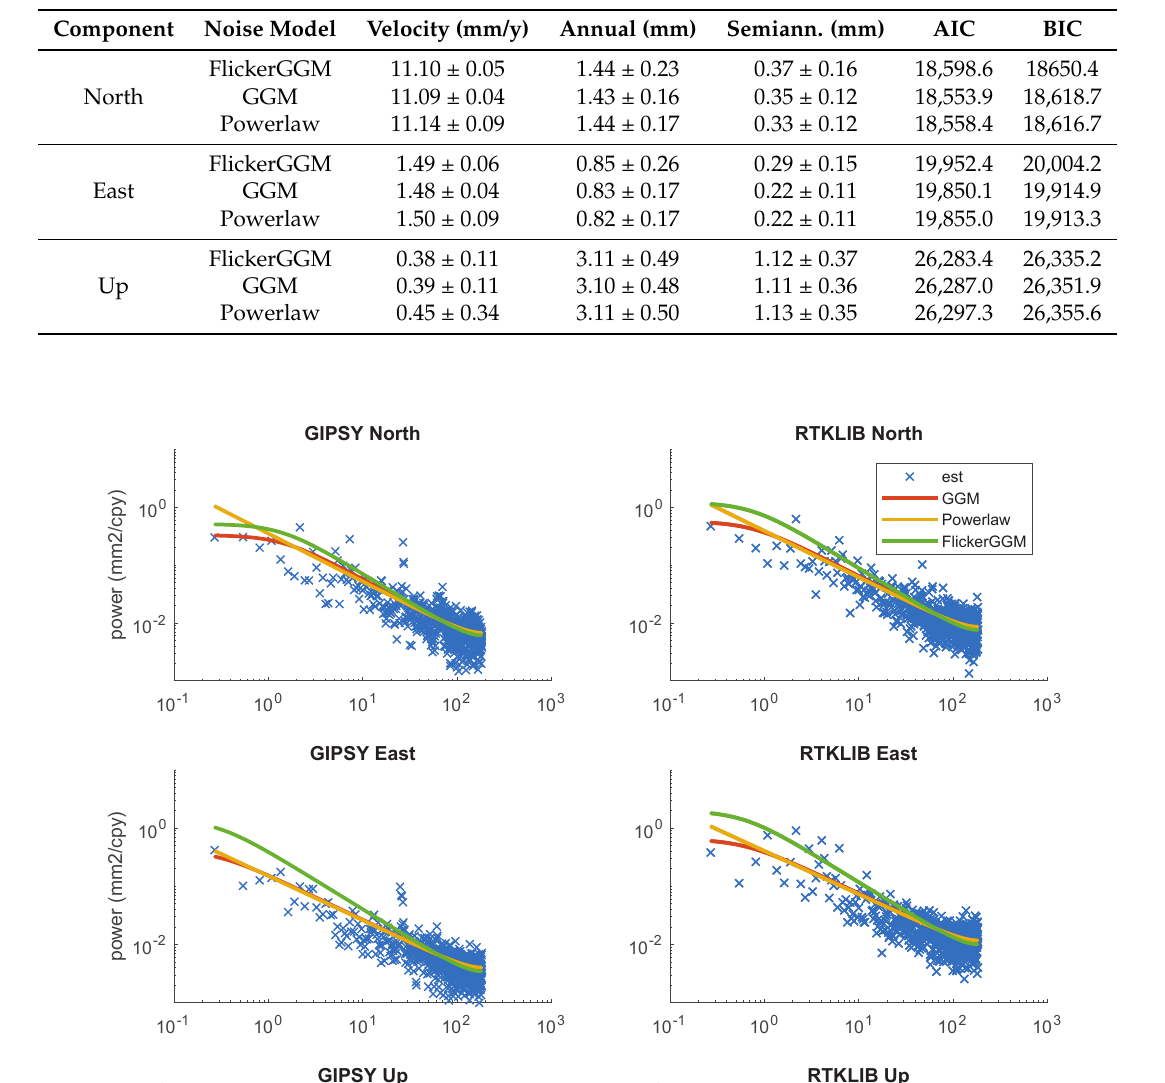
Table 6. Estimated trend and seasonality parameters for different noise models for the RTKLIB solution.